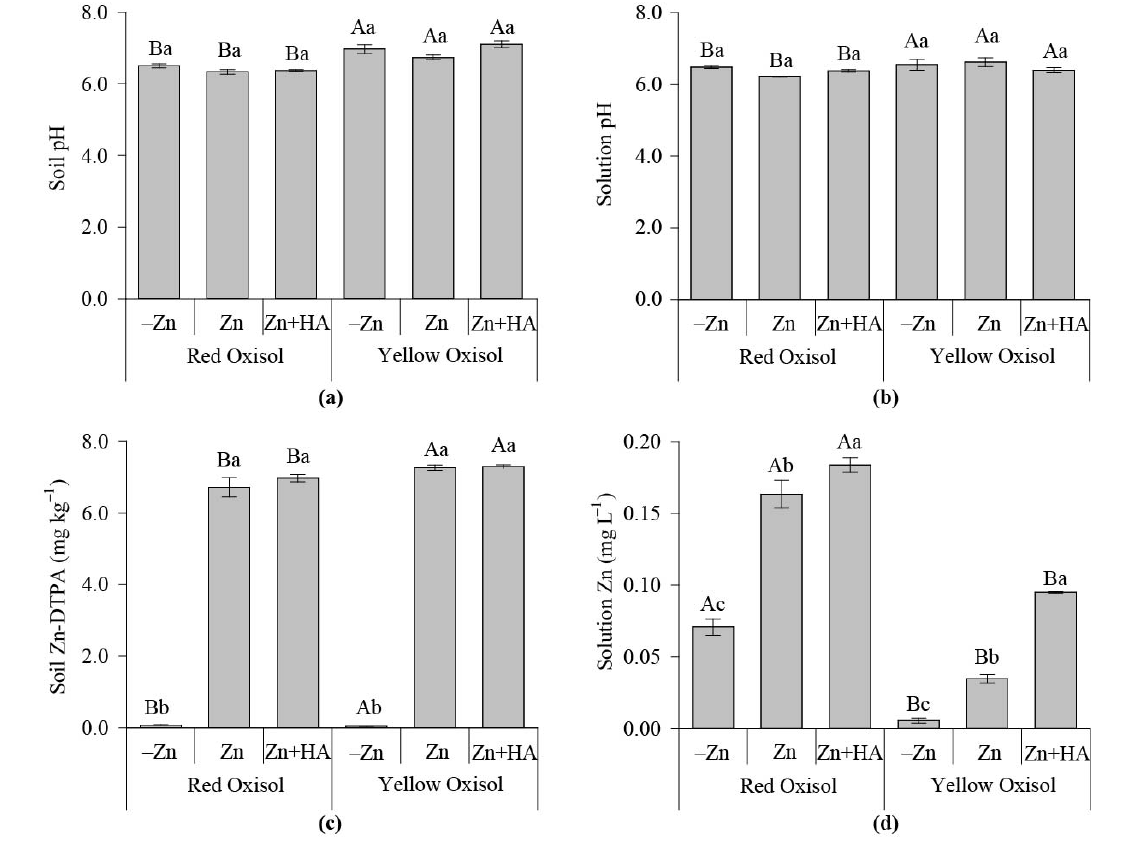
Figure 1. Effects of Zn fertilization and humic acid (HA) on soil pH and Zn availability in contrasting Oxisols cultivated with maize. Soil pH ( a ); soil solution pH ( b ); soil available Zn by the DTPA method ( c ); Zn in soil solution ( d ). Bars followed by the same capital letter means that the soil type properties differ regarding the Zn fertilization strategies studied according to the Tukey test ( p < 0.05). Bars followed by the same lowercase letter mean that crop traits do not differ regarding the Zn fertilization strategies adopted, again, according to the Tukey test ( p < 0.05), within each soil type. − Zn: no-Zn